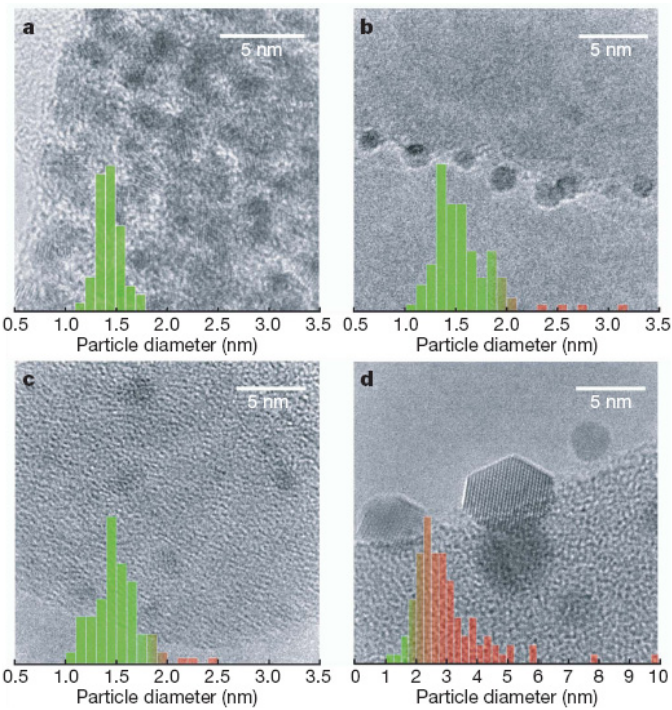
Figure 10. TEM images of overlaid with corresponding particle size distribution for Au nanocluster